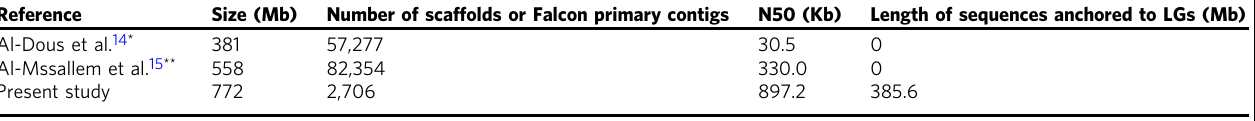
Table 1 Statistics of the BC4 male date palm assembly and the previously published cultivar Khalas assemblies Reference Size (Mb) Number of scaffolds or Falcon primary contigs N50 (Kb) Al-Dous et al.